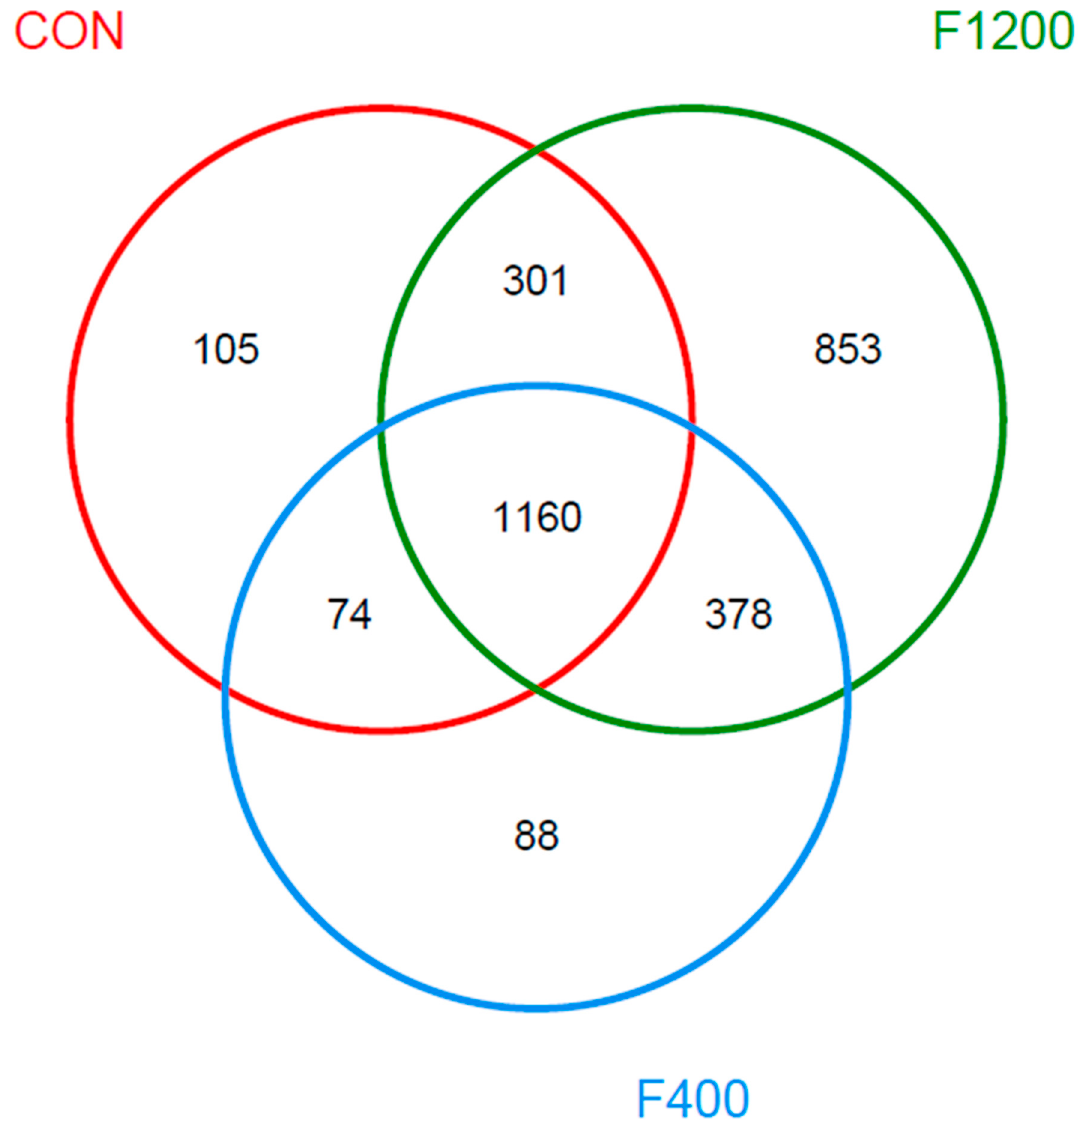
Figure 5. E ff ects of dietary fluoride level on Venn diagram of cecal microbiota between groups ( n = 5). Venn diagram was obtained at operational taxonomic units (OTUs) levels (97% similarity threshold). CON, the control group basal diet; F400 and F1200, diets supplemented with 400, and 1200 mg F / kg feed from sodium fluoride, respectively.